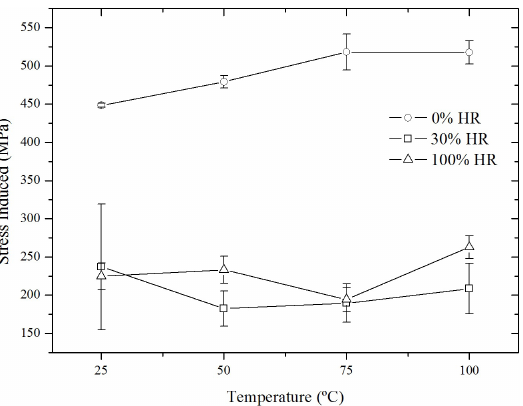
Figure 6 - Stress induced as a function of lamination degree and temperature.